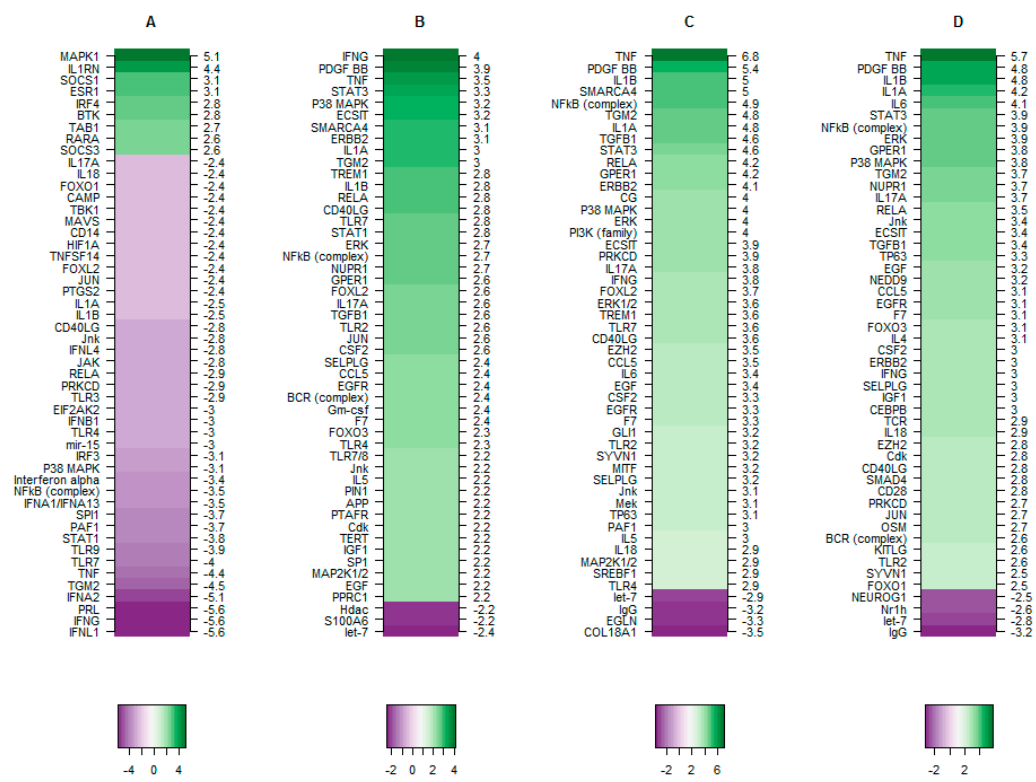
Figure 7. The Z-scores of the top 50 upstream regulators. The top 50 upstream regulators identified in study ( A – C ) are represented as a network plot. The four central nodes ( A – D ) and their corresponding edges (the coloured lines) represented in this figure correspond to four independent datasets. Dataset A: hTERT-HM cells overexpressing TBX2 (light blue lines, source current study).Dataset B: Preterm Labour in human myometrium (pink lines, source current study).Dataset C: Term labour in human myometrium (light green lines, source Chan et al., 2014). Dataset D: Term labour in human myometrium (purple lines, source Sharp et al., 2016).